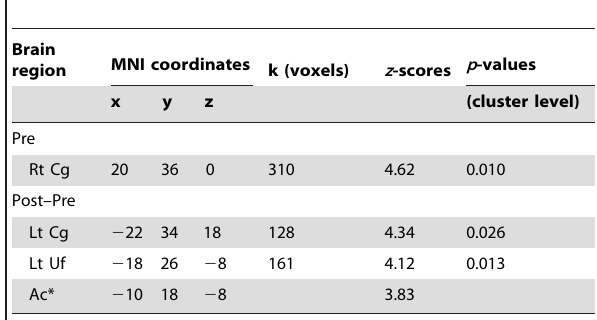
Table 3. MNI coordinates, voxel sizes, z -scores, and P -values for results of the SPM